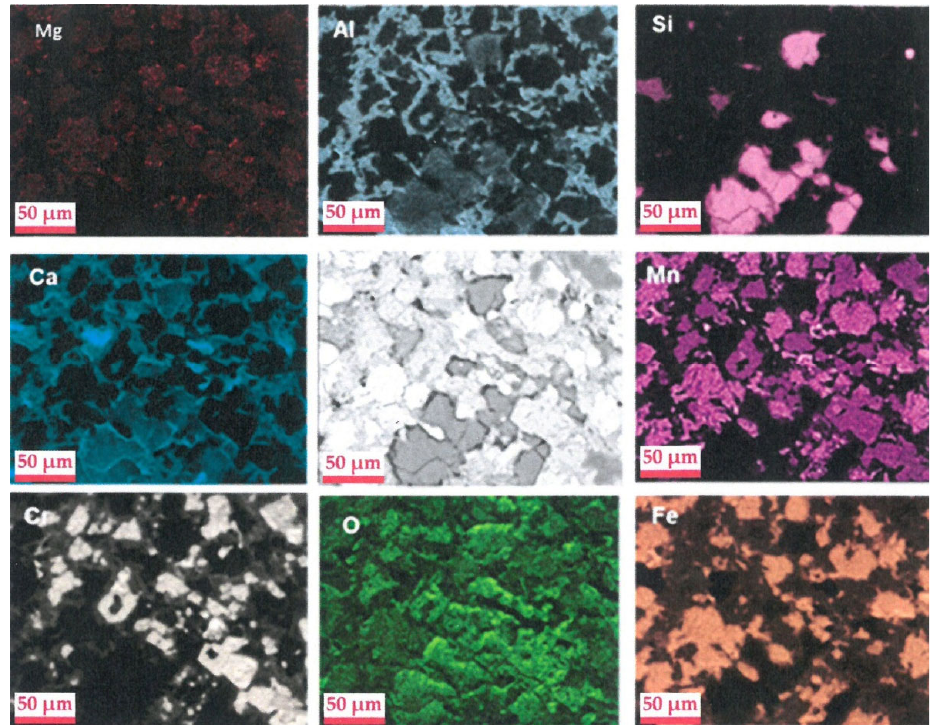
Figure 7. Energy dispersive spectroscopy (EDS) mapping from scanning electron microscopy of the elements Al, Si, Ca, Cr, Mn, Fe, and O in EAF slag.